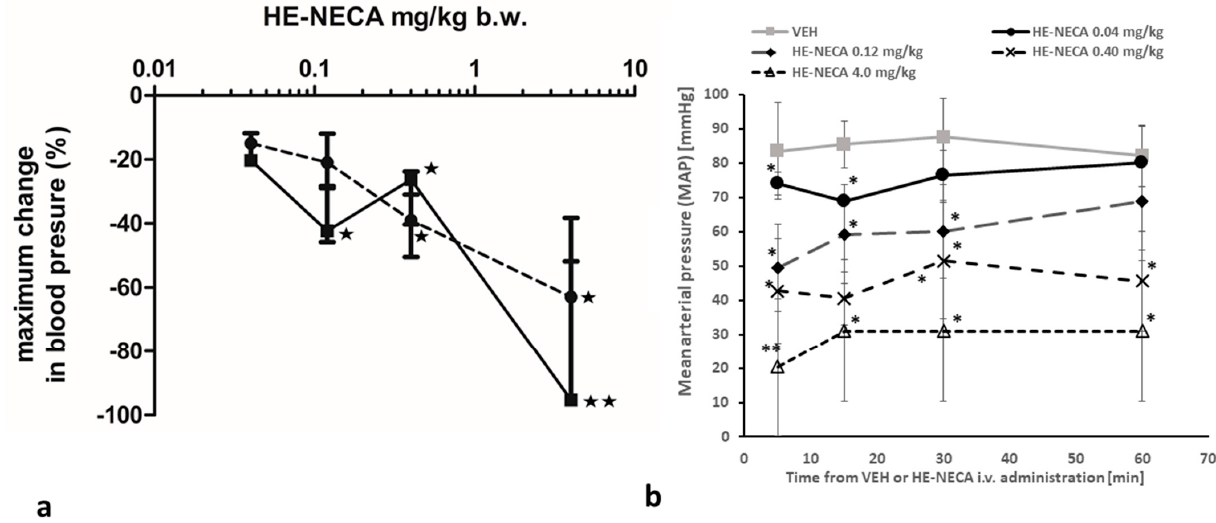
Figure 6. ( a ) Effects of HE-NECA on systolic (SBP) and diastolic (DBP) blood pressure in mice. Data, shown as median with IQR ( n = 4–5), present the maximum change in diastolic (circles) and systolic (squares) blood pressure in comparison to the initial blood pressure (measured prior to HE-NECA injection). A Mann–Whitney U test was used to evaluate statistical significance: * p < 0.05, ** p < 0.01. For a vehicle-treated group (concentration of HE-NECA equal to 0) ∆ SBP and ∆ DBP were 8.55 ± 4.11 and 12.50 ± 0.96 mmHg, respectively. ( b ) Mean Arterial Pressure (MAP) changes within 60 min after HE- NECA i.v. treatment in ketamine/xylazine anesthetized mice. Note that VEH values are diminished due to anaesthesia. Data are shown as a Mean ± SD; * p < 0.05; ** p < 0.01 vs VEH; n = 4–5.